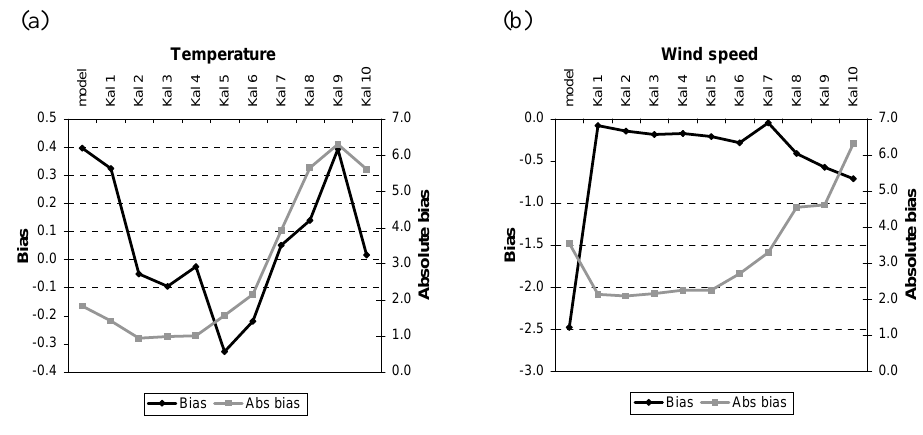
Fig. 5. Bias and absolute bias of (a) temperature and (b) wind speed for model and different Kalman filters outputs (Case II). Fig. 2 are characteristic and representative of the general